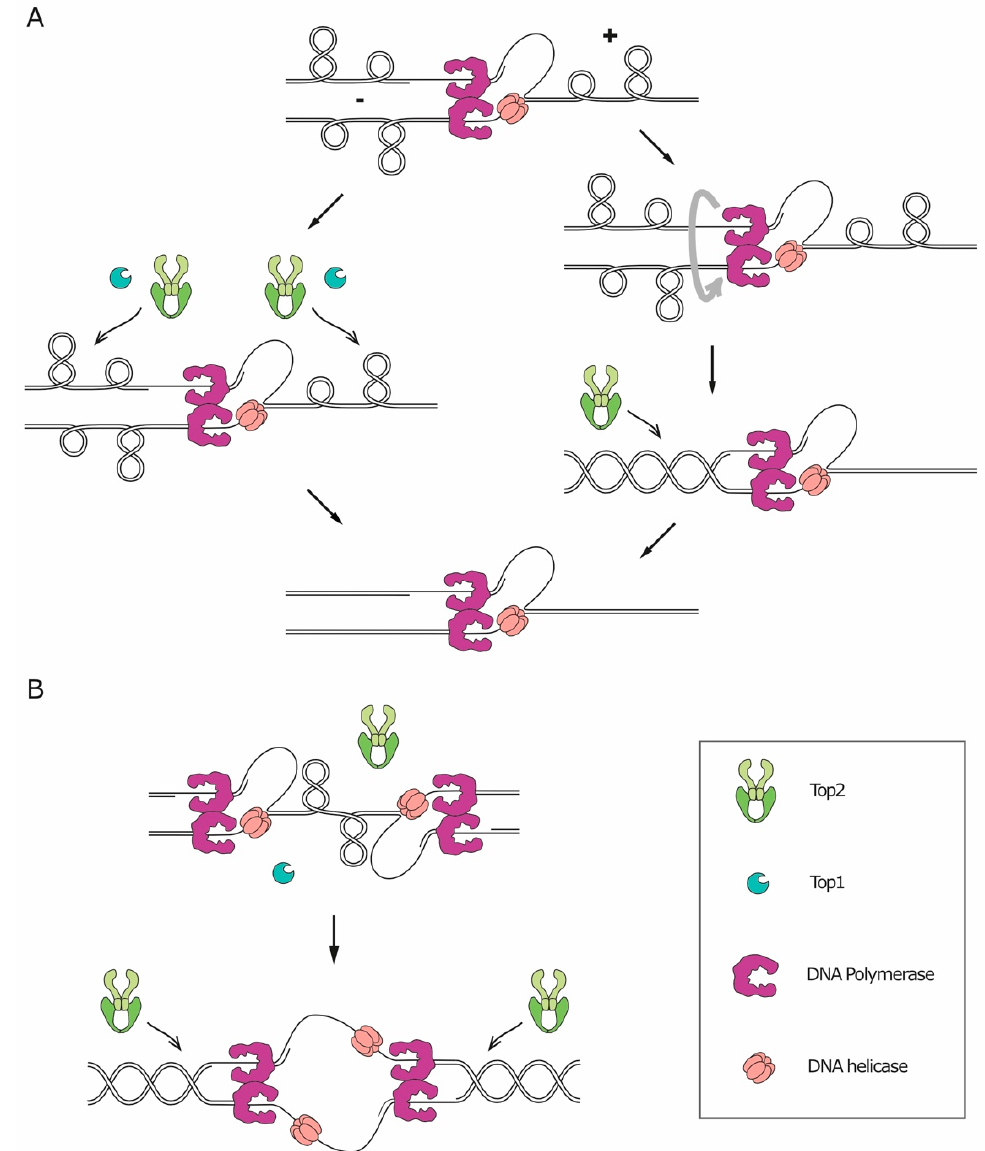
Figure 3. Relaxation of replication-induced supercoils occurs through topoisomerase action or fork rotation. ( A ) During replication elongation, positive and negative supercoiling accumulate ahead and behind of the replication fork, respectively. Replication-induced supercoil can be relaxed by both Top1 and Top2 (left). Alternatively, rotation of the replisome transfers the supercoiling accumulated ahead of the fork to the region behind the fork, determining the formation of precatenanes between the duplicated DNA molecules, which are resolved by Top2 (right). ( B ) At replication termination, the DNA between the two converging replisomes is inaccessible to topoisomerases. Therefore, fork rotation becomes the preferred route for the relaxation of replication-induced supercoils. Supercoils can be relaxed by either Top1 or Top2, whereas catenanes can only be removed by Top2.